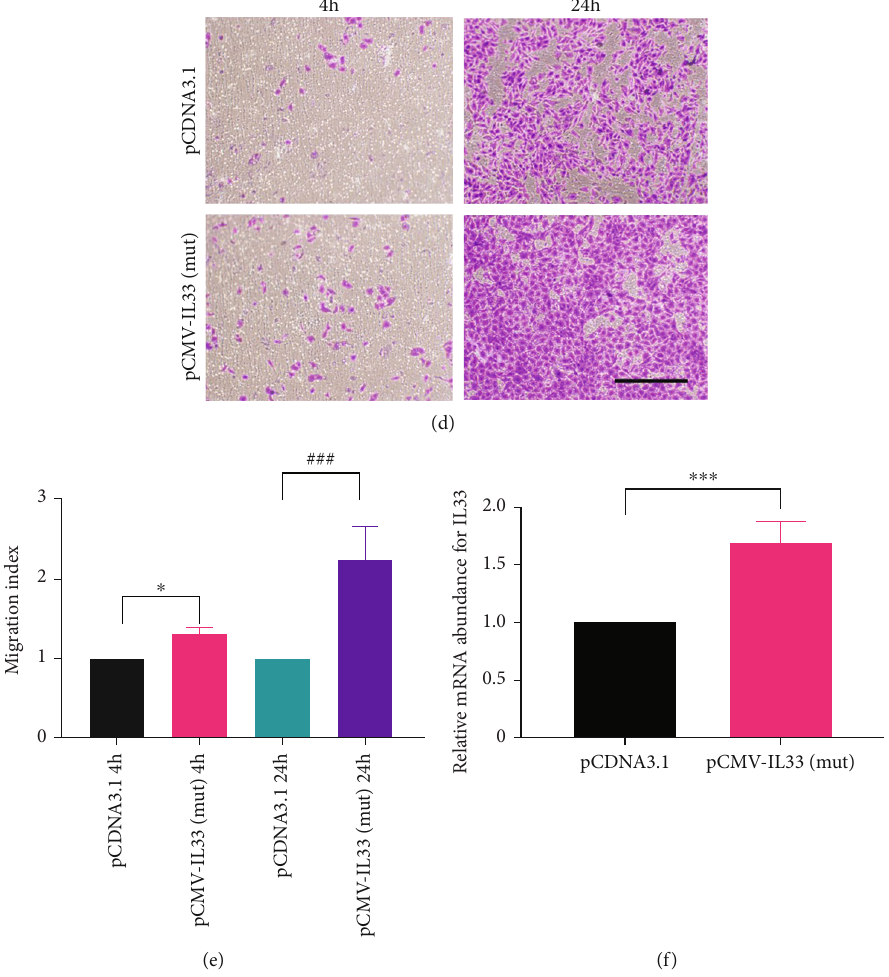
Figure 4: rs10975519 mutation on IL-33 gene promoted the mobility and migration of HK2 cells. (a) Wild-type (pCDNA3.1) and mutated (pCMV-IL-33) plasmids of rs10975519 were constructed for further veri fi cation. (b) HK2 cells transfected with pCDNA3.1 or pCMV-IL- 33(mut) plasmids were wounded by a pipette (c). Quantitation of the migrated cells was measured by the mobility index, which was determined by the formula “ the numberof cellsthatmigrated in thepCDNA3 : 1 group/thenumberof cells thatmigratedinthe pCDNA3 : 1 grouporthe mutatedgroup . ” (d) The HK2 cells transfected with the pCMV-IL-33 or pCDNA3.1 plasmids were seeded in the top chamber for 4h and 24h. (e) HK2 cells migrating through the membrane were quanti fi ed by the migration index, which is calculated by the formula “ the numberof cellsthatmigratedinthe pCDNA3 : 1 grouporthemutatedgroup/thenumberof cellsthatmigratedin thepCDNA3 : 1group : ” (f) RT-PCR results indicated higher expression of IL-33 mRNA was seen in the mutated group comparing with the pCDNA3.1 group. Abbreviation: RT-qPCR: real-time